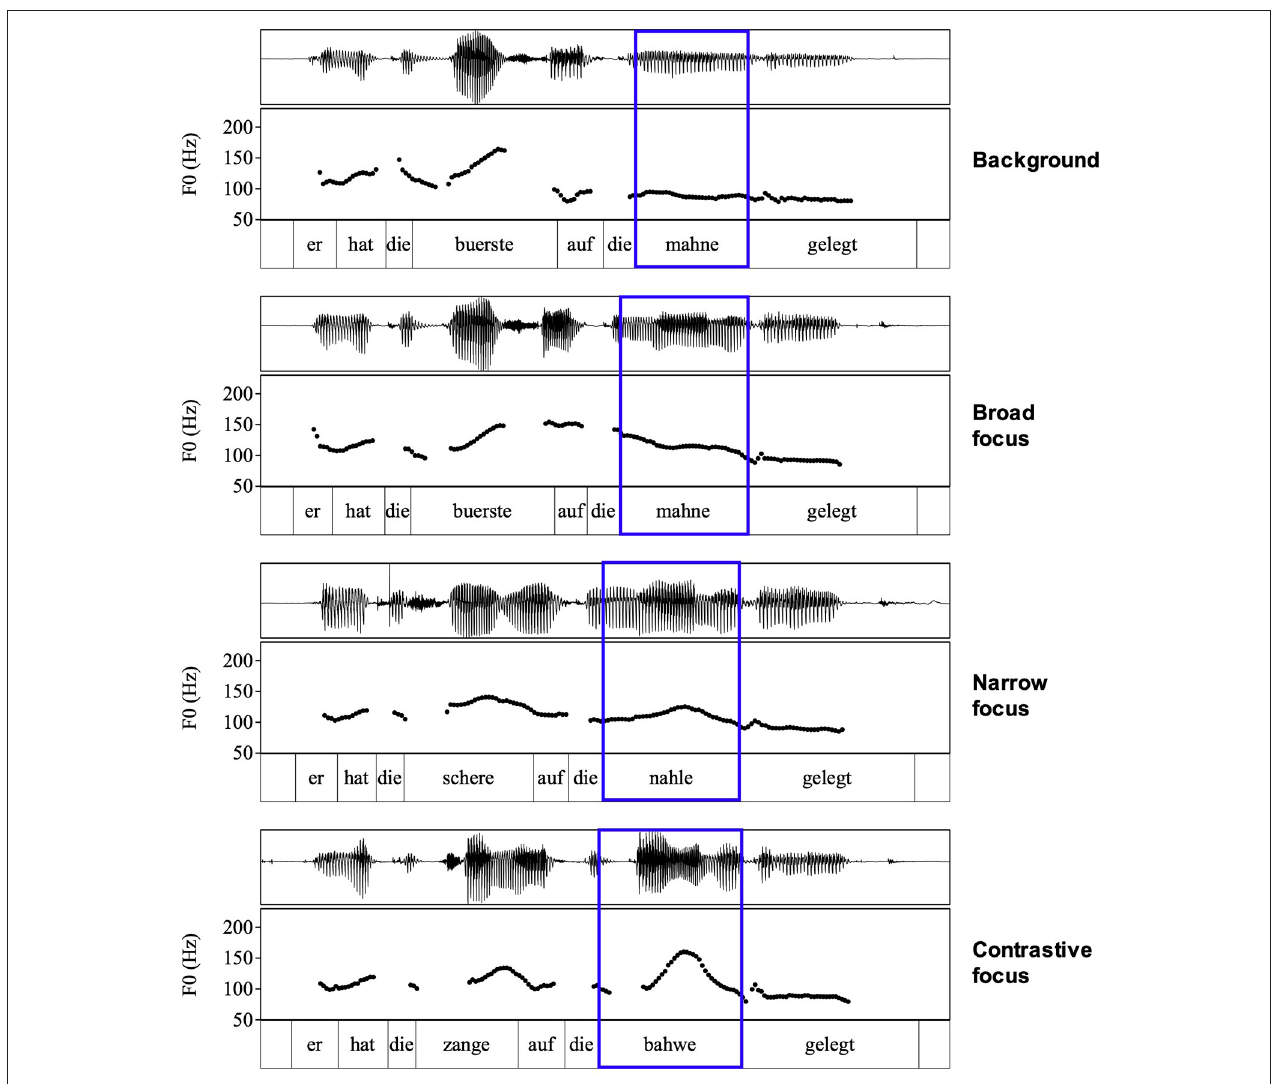
FIGURE 1 | Examples for all four